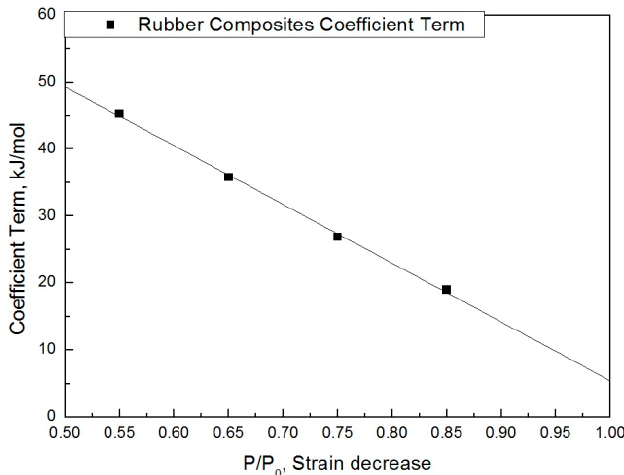
Figure 12. Coefficient term according to characteristic value.